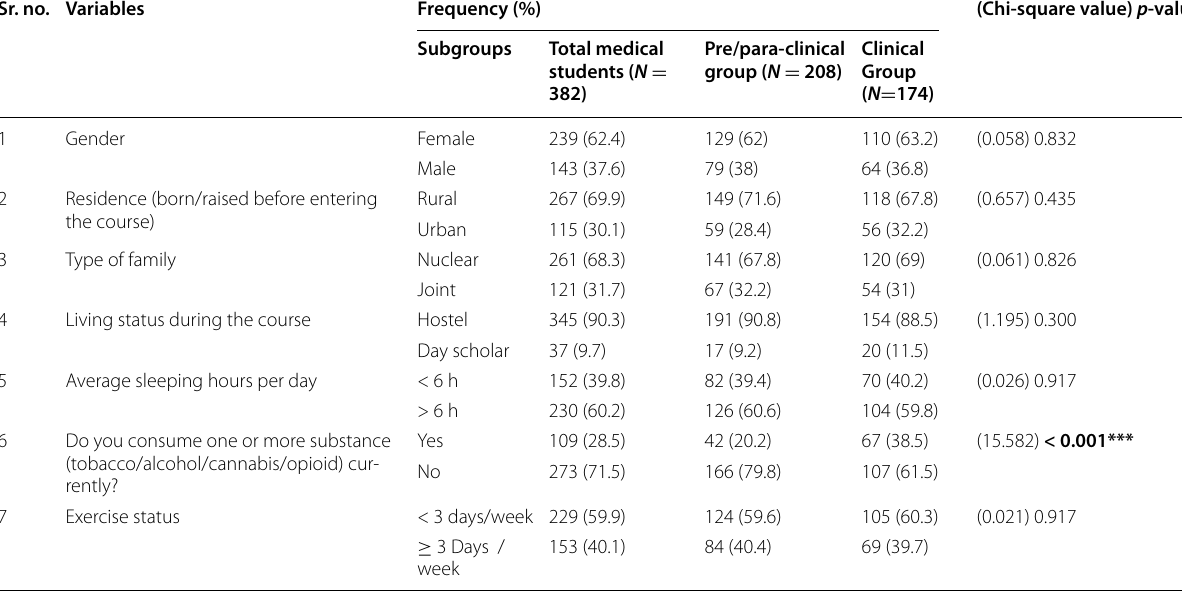
SD Standard deviation *** p < 0.001